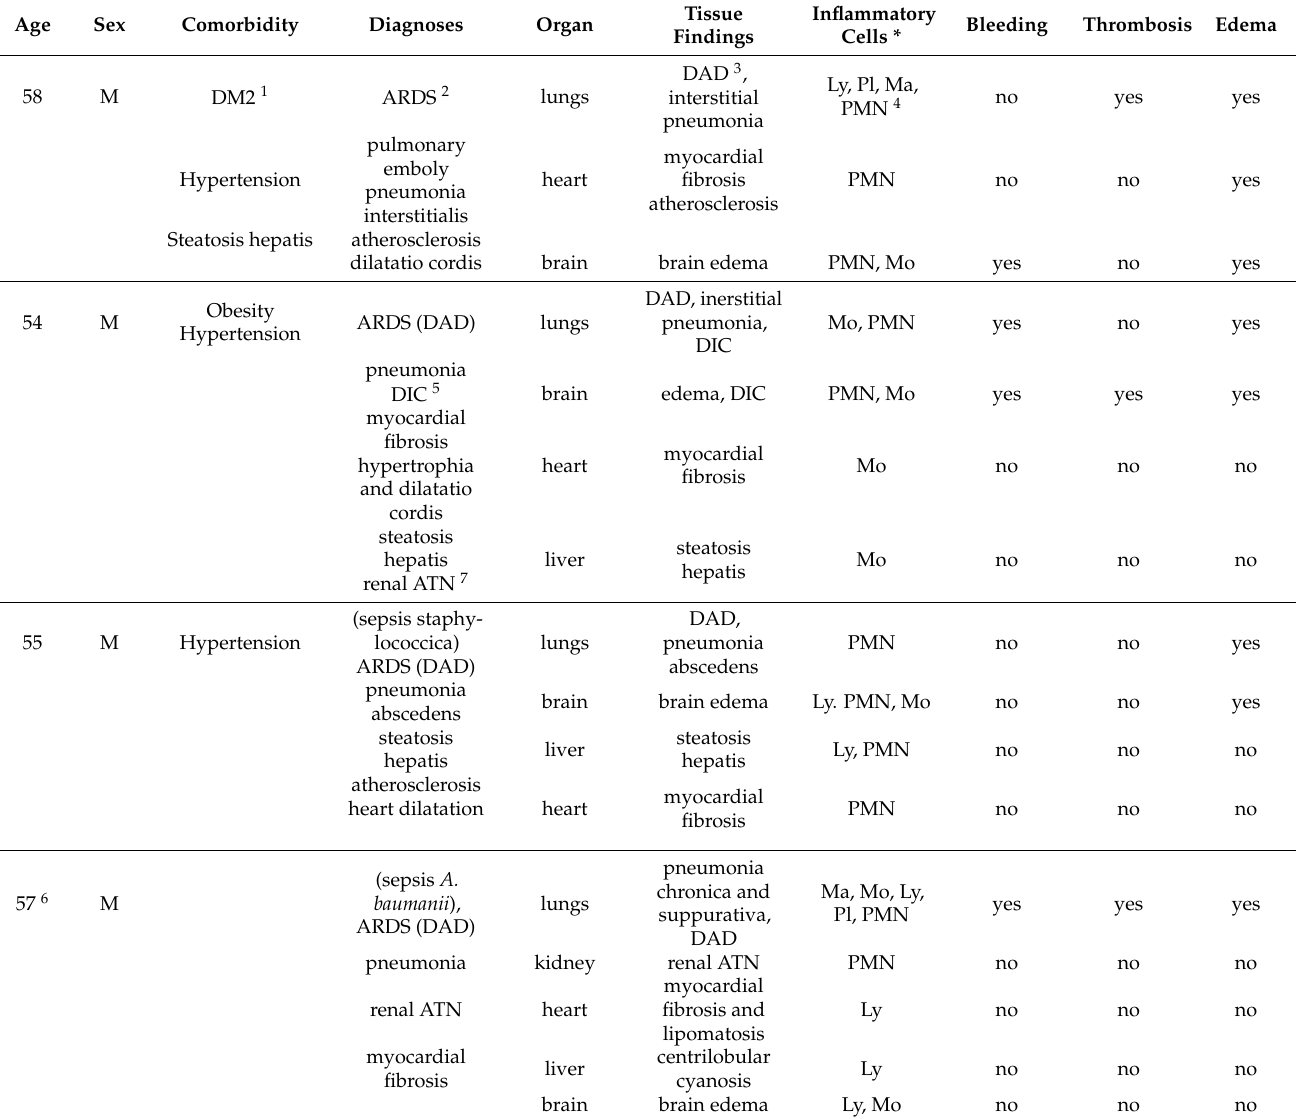
Table 1. Major clinical and autopsy findings of patients deceased after lethal